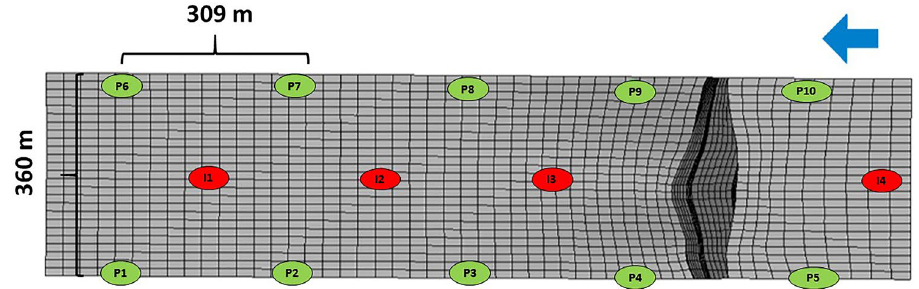
Fig. 7 Well location. The model comprises 14 wells, of which 10 are producers and 4 are